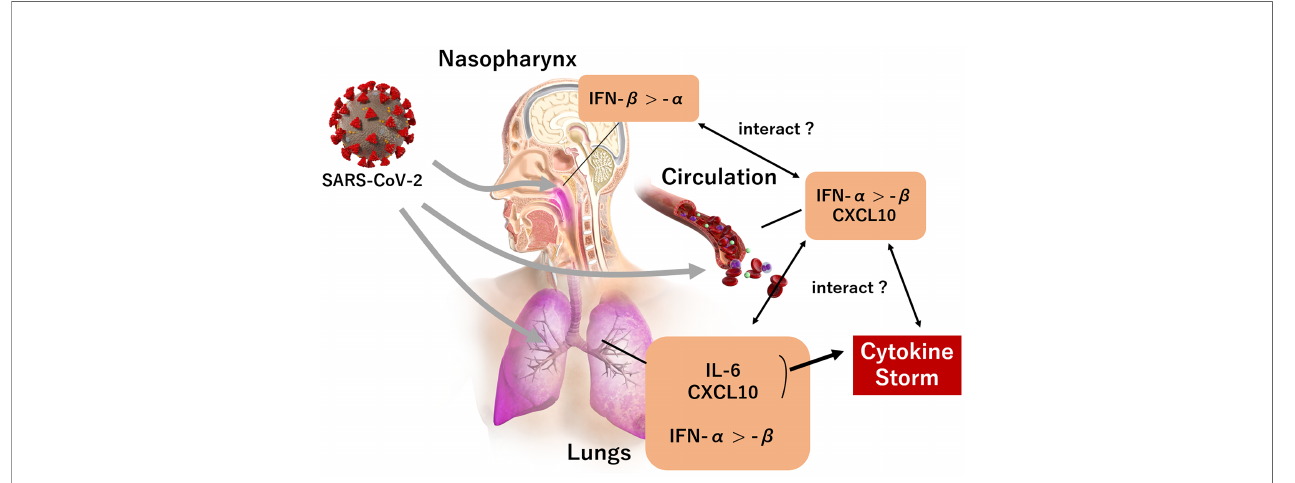
FIGURE 6 | The landscape of IFN-I and predominant cytokines (CXCL10, IL-6) during the early phase of a SARS-CoV-2 infection. A SARS-CoV-2 infection in the nasopharynx induces IFN- b expression rather than IFN- a . IFN- a , IL-6, and CXCL10 expression is induced when the infection reaches the lungs, rather than IFN- b ; and the expression of IFN- a and CXCL10 is induced by the presence of SARS-CoV-2 infection in circulation. An increase of IL-6 and CXCL10 in pulmonary circulation subsequently trigger a cytokine